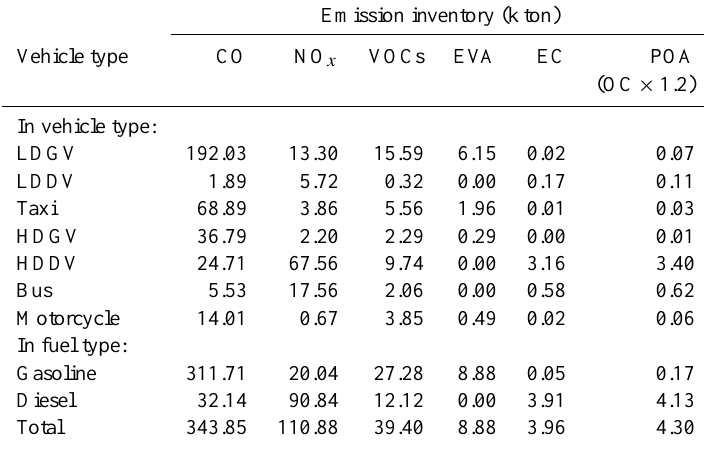
Table 3. Vehicle emission inventory in